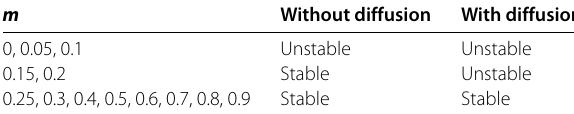
Table 1 Stability of E ∗ ( u ∗ , v ∗ ) for system (4.1) m Without diffusion With